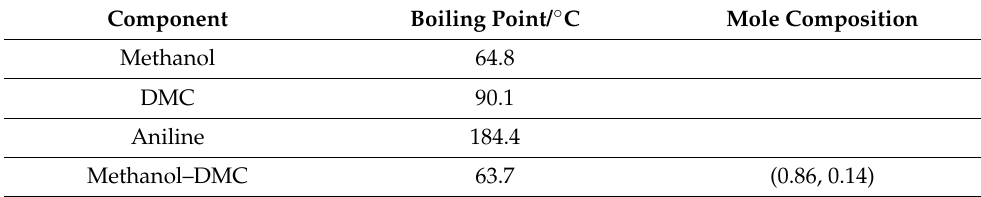
Figure 3. The simulation process of CEP.